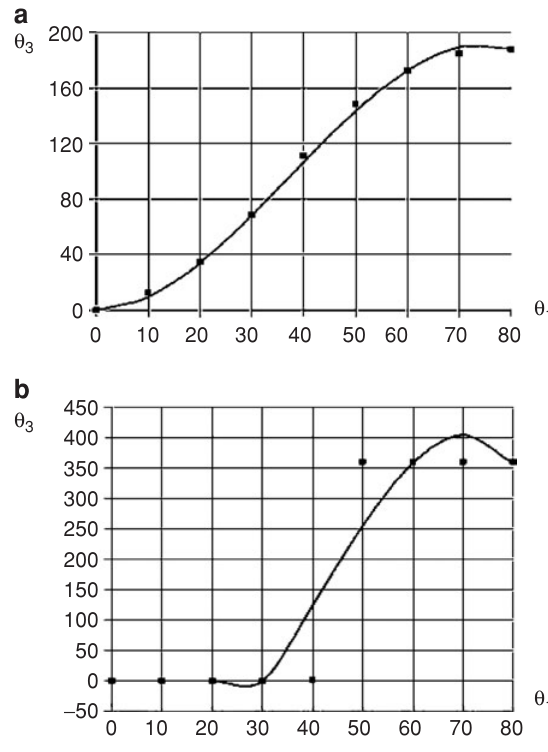
Figure 7 Results of the simulation in Figure 6 by means of closure equations as square cubic dots and as a cubic line interpolation: (a) θ 2 vs. θ 1 ; (b) θ 3 vs. θ 1 (angles are expressed in